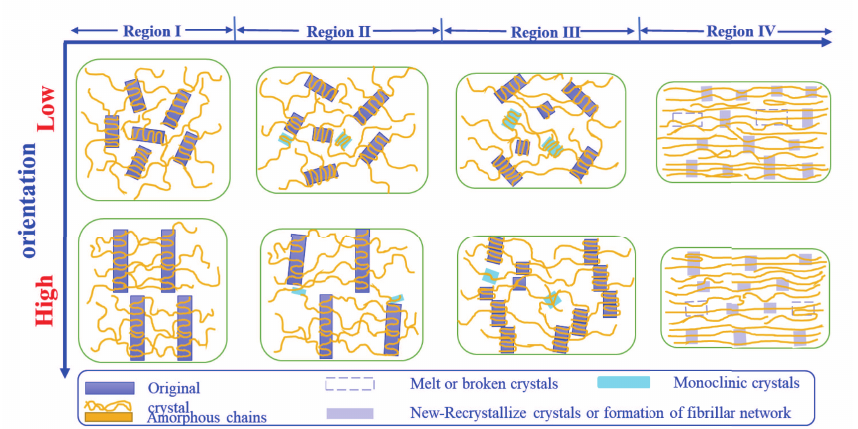
Figure 7. Schematic illustration of the microstructural deformation mechanisms for less and highly- oriented precursor films. The tensile direction is